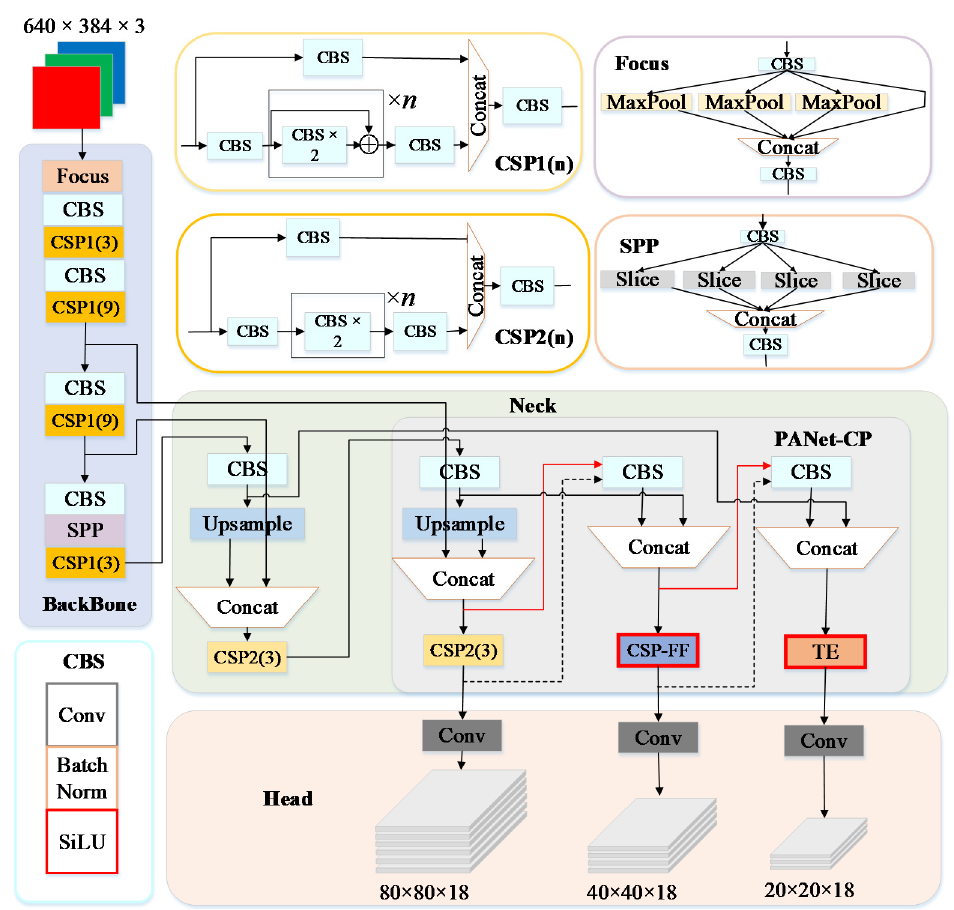
Figure 3. Structure of the YOLOv5s-FP (where TE corresponds to the transformer encoder in Figure 4, CSP-FF corresponds to feature fusion-based CSP in Figure 6, and PANet-CP corresponds to collaboration perception-oriented PANet in Figure 7), with structural improvements marked in red boxes, new skip connections marked with red lines, and removed connections marked with dashed lines.